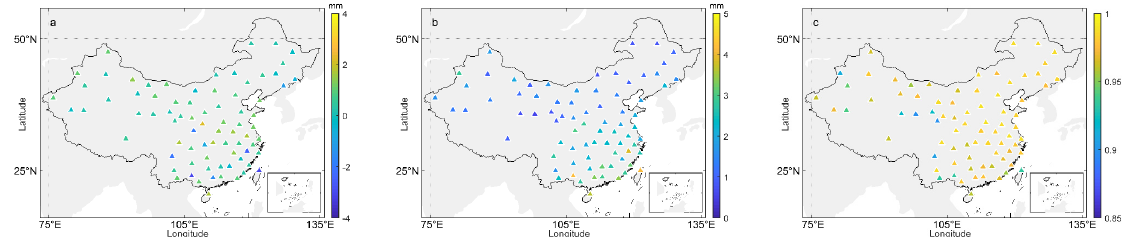
Figure 5. ( a ) Bias, ( b ) RMS, and ( c ) correlation coefficient between RS-PWV and ERA-PWV in the six-year period studied from 2013 to 2018 over each of the 78 radiosonde stations.